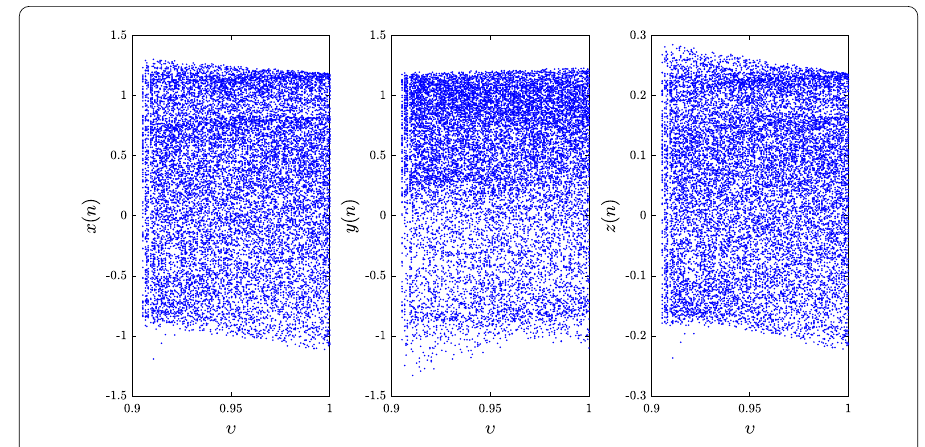
Figure 5 Bifurcation diagram of the fractional Stefanski map with υ ∈ [0,1] as the critical parameter,